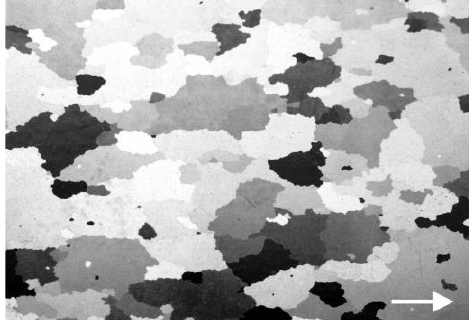
Figure 1. A photograph of the polycrystalline structure of GO steel after removal of isolating coatings. The arrow size on the photo is around 1 cm, whereas its direction depicts the rolling direction. Source: Encyclopedia Magnetica, https://e-magnetica.pl/file/grains_in_go_steel_jpg, author: Stan